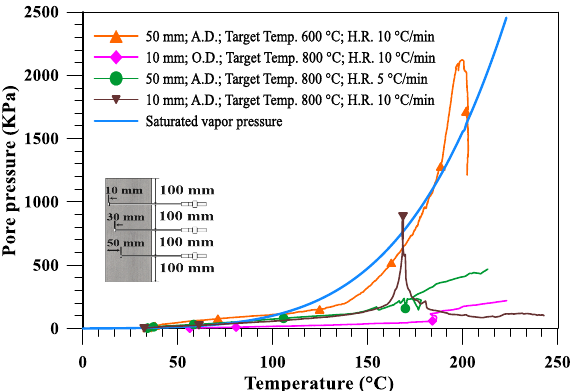
Figure 15. Comparison between the pore pressure and saturated vapor pressure curves.